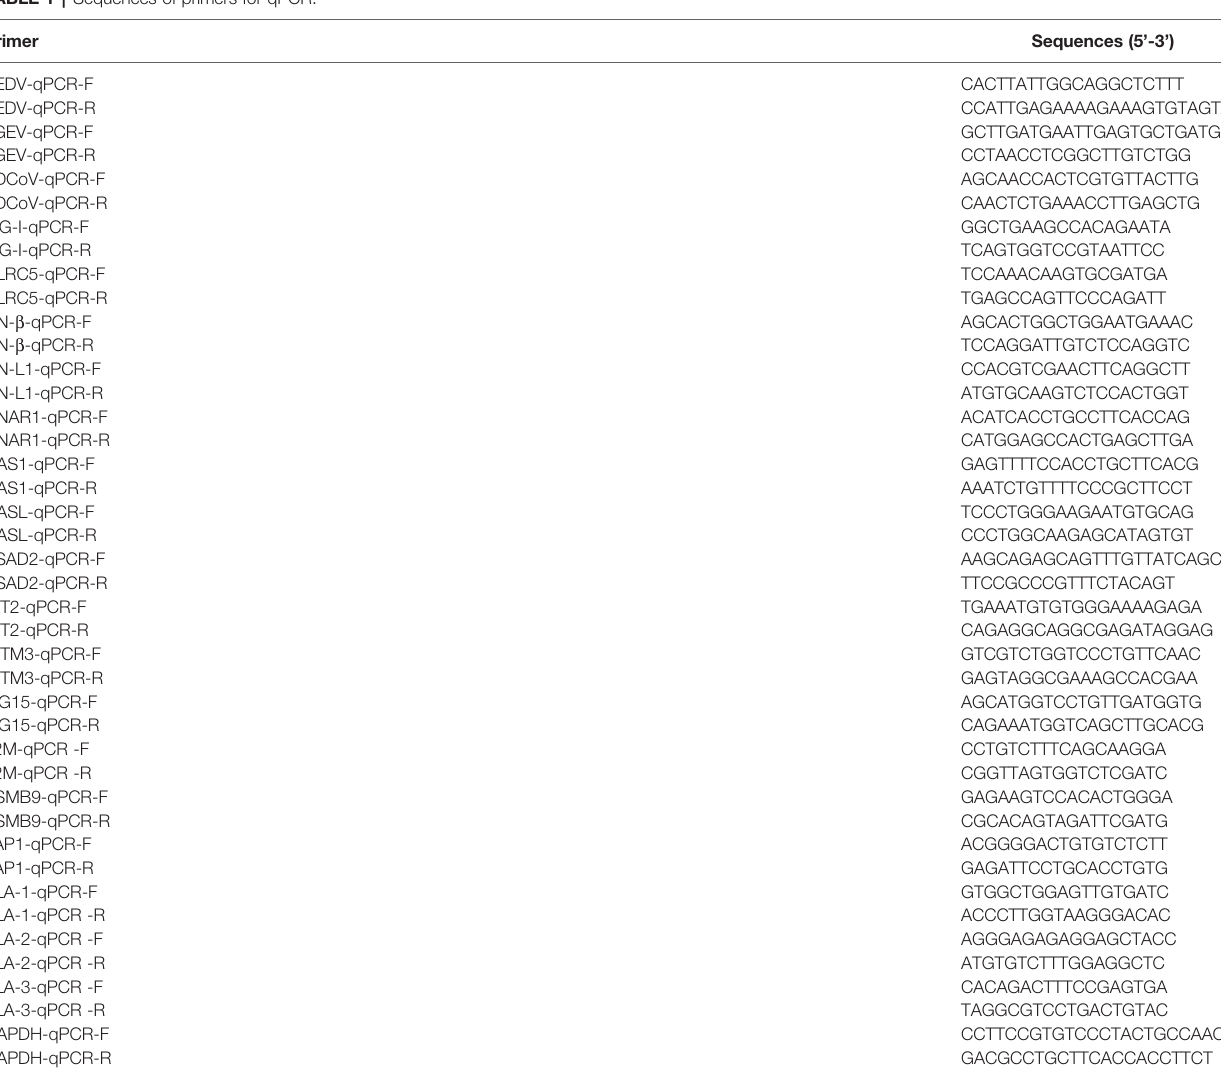
TABLE 1 | Sequences of primers for